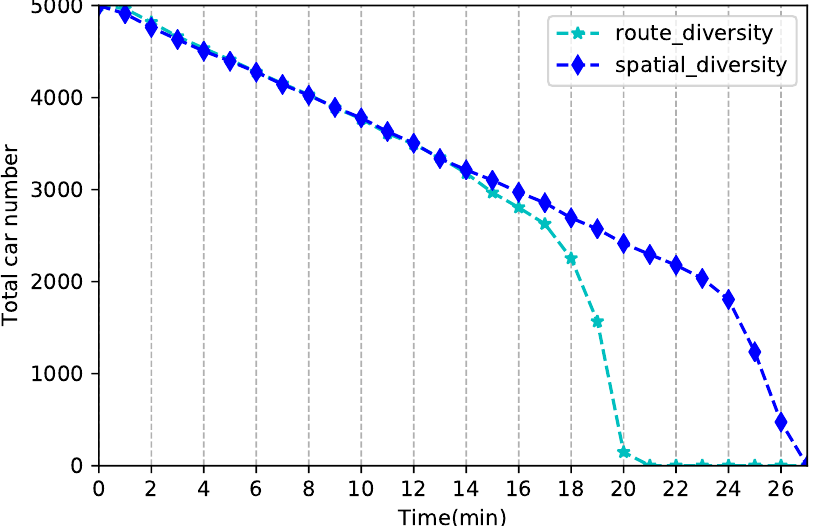
Figure 9. The number of vehicles remaining in the evacuation center over